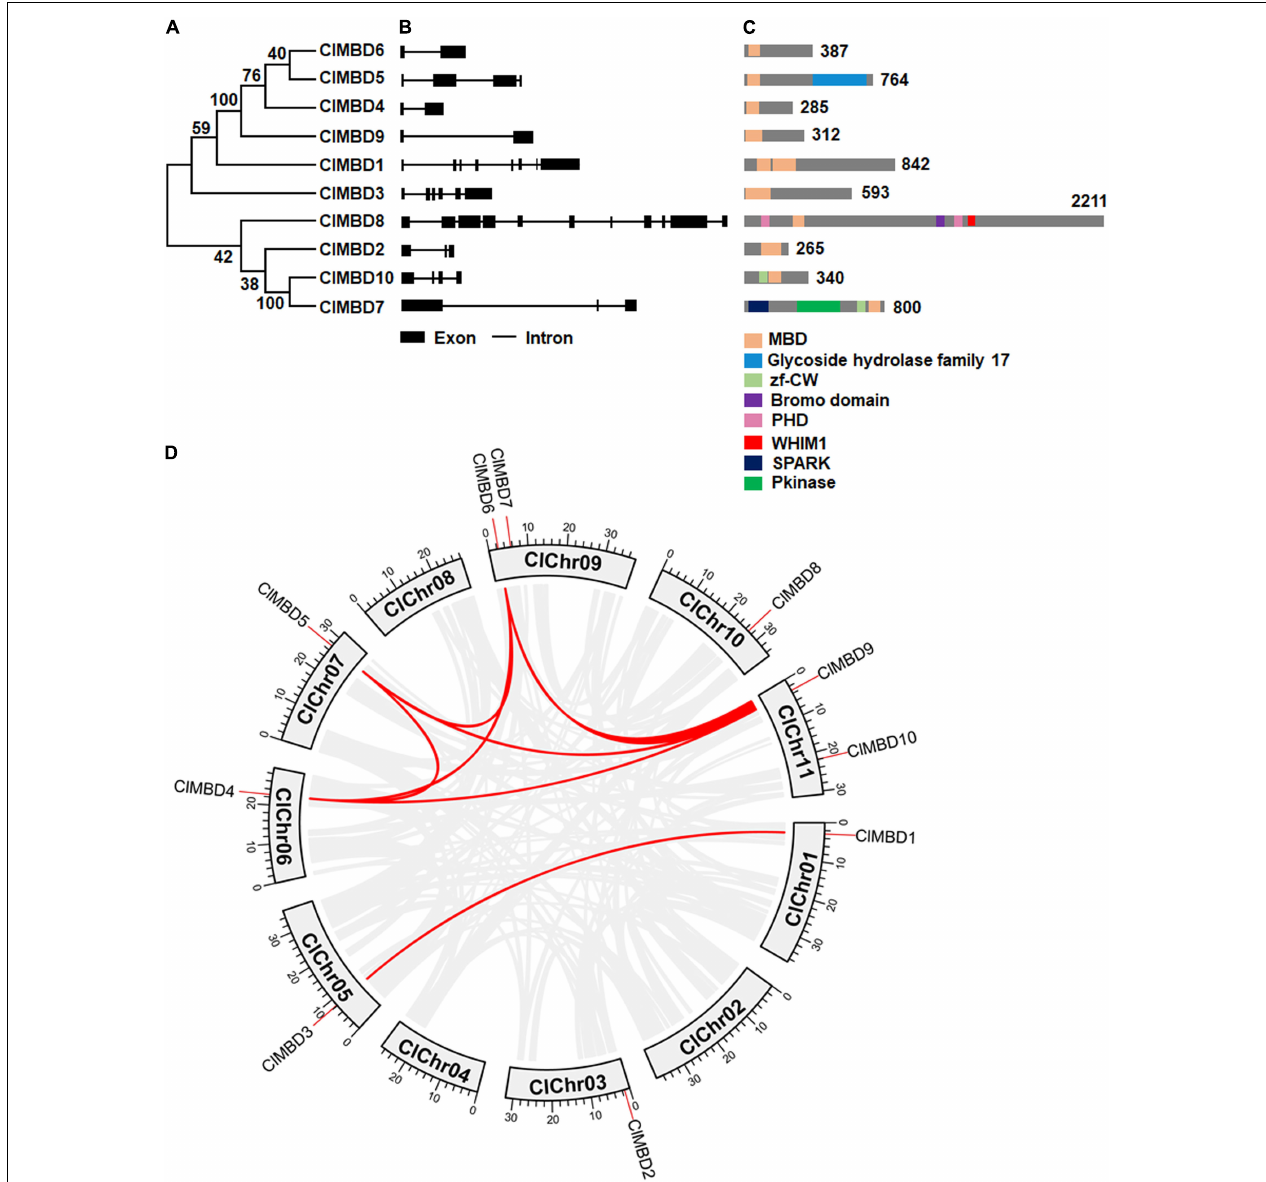
FIGURE 1 | Phylogenetic tree and structure of genes and proteins of the watermelon ClMBD family and the evolutionary relationships among the watermelon ClMBD family members. (A) Phylogenetic relationships of the watermelon ClMBDs. Clustal X2 program was used for multiple sequence alignments and neighbor joining method of MEGA7 was used for constructing the phylogenic tree. (B) Structure of the watermelon ClMBD genes. The exon-intron structure of the coding regions of the ClMBD genes are shown. Filled boxes indicate exons while lines represent introns. (C) Conserved domains and their organization in the watermelon ClMBD proteins. (D) Interchromosomal relationships of the watermelon ClMBD genes. Gray lines indicate the synteny blocks in the genome, and the red lines indicate tandem duplications of the ClMBD gene